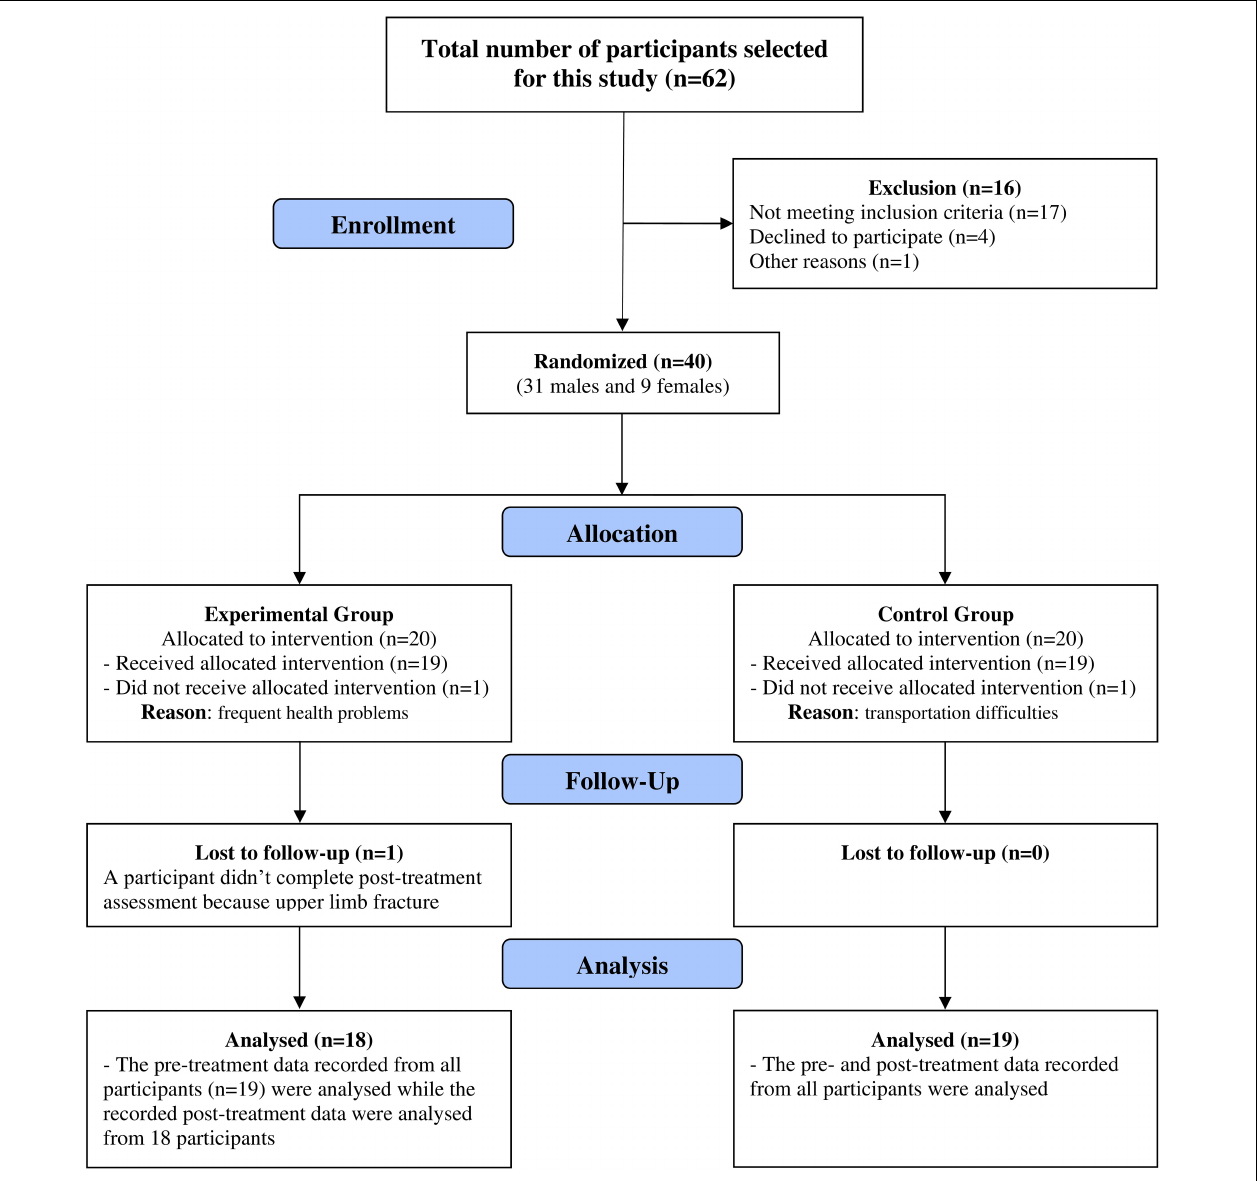
FIGURE 1 | Flow diagram of the